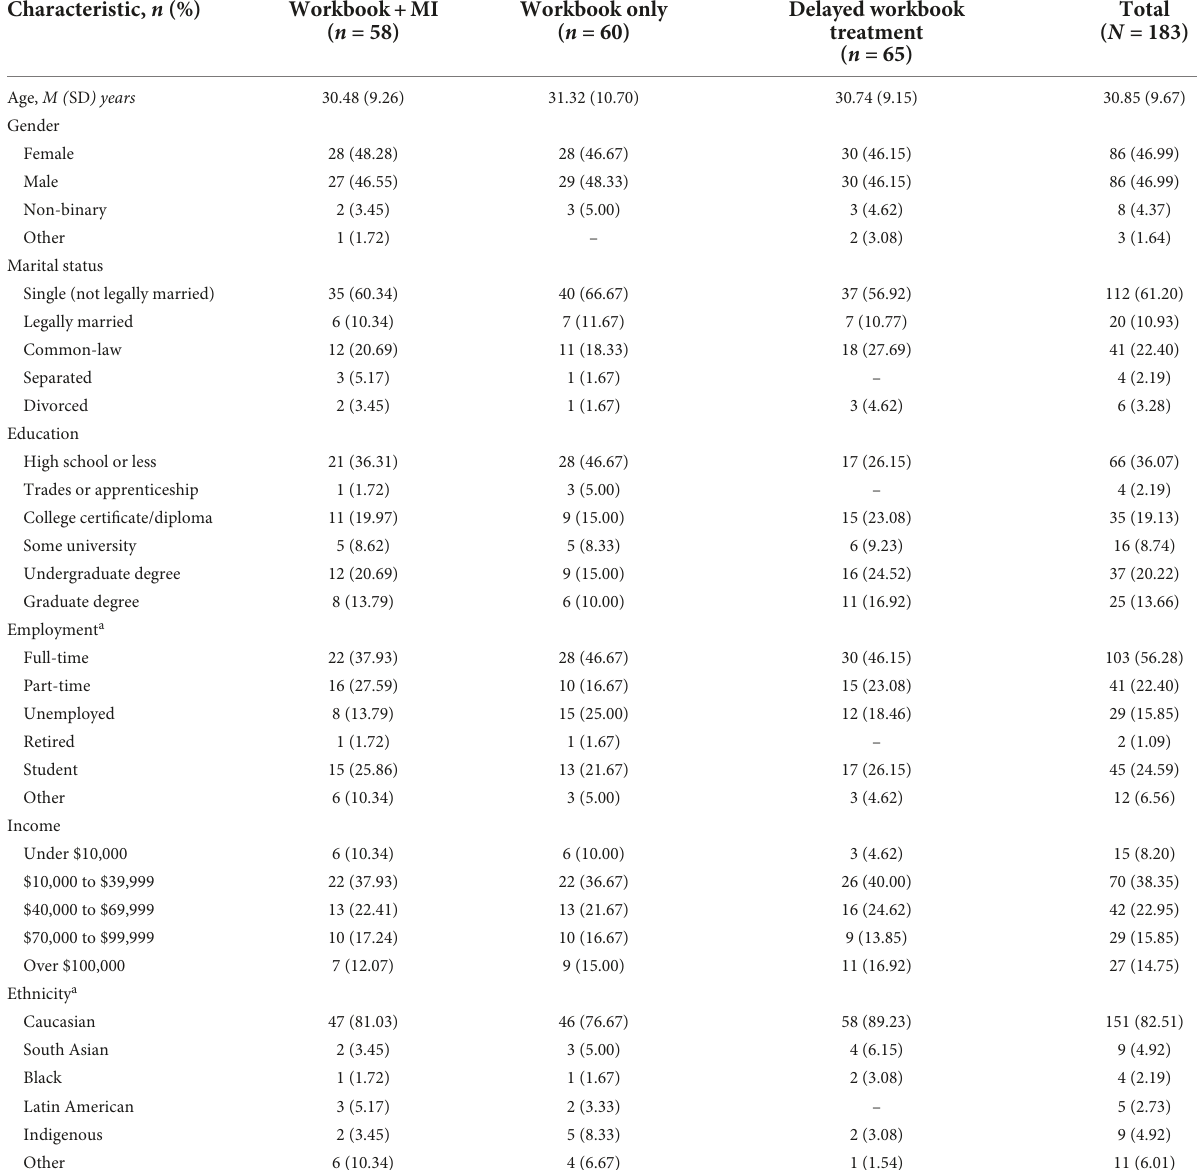
TABLE 2 Participant demographic characteristics by group and across entire